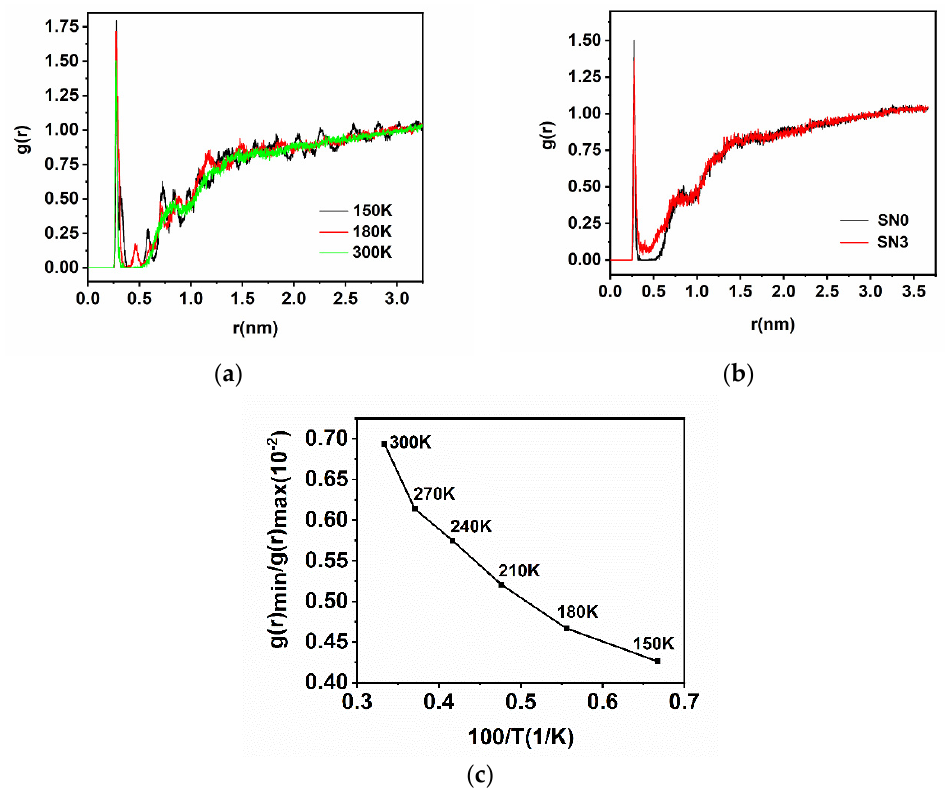
Table 3. The value of the first peak of RDF in each system.